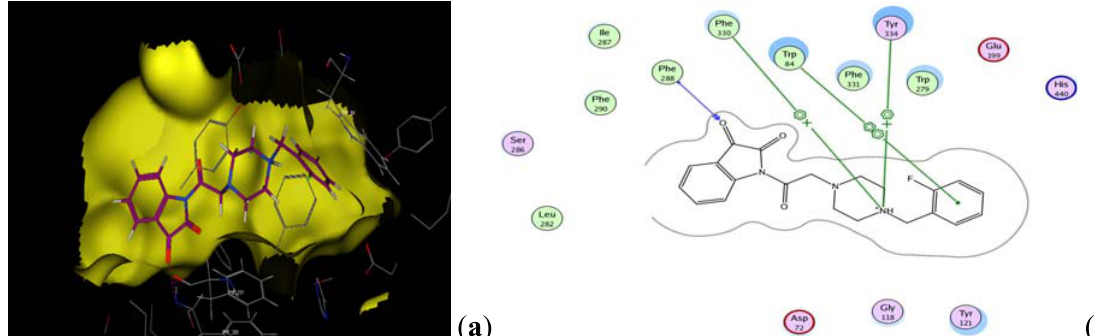
Figure 5. ( a ) Docked pose of III ( b ) Simplified structure showing interaction between VII AChE active